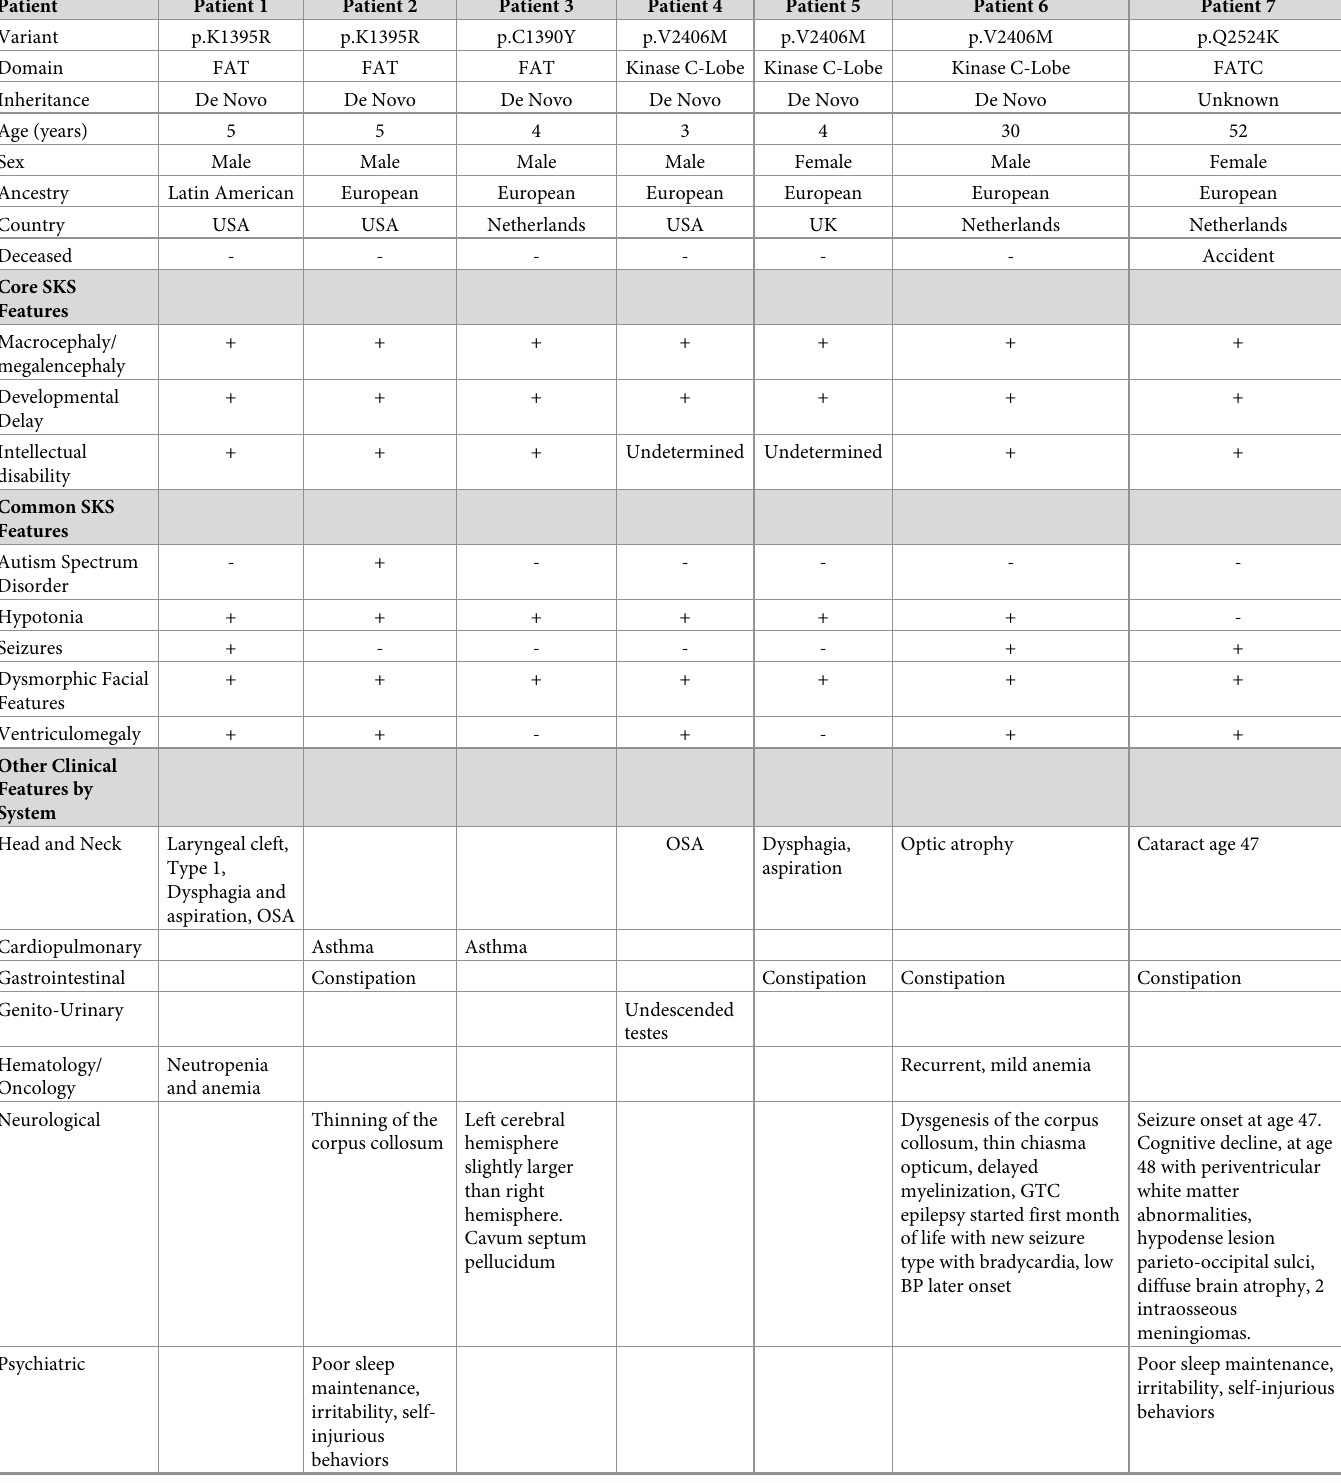
Table 1. Summary of Clinical Features of Smith-Kingsmore Syndrome in Patients with Novel